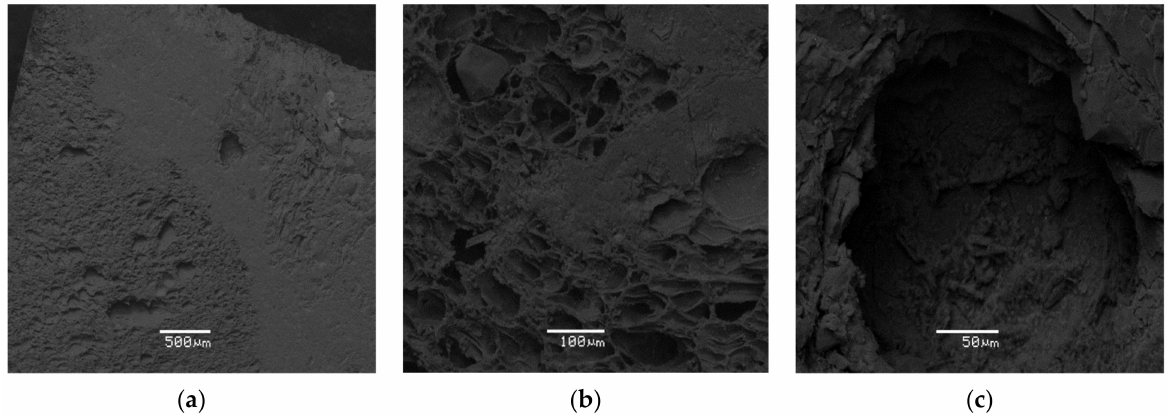
Figure 8. SEM photos of PeCaPu concrete samples: ( a ) ITZ area, ( b ) and ( c ) aggregate pore filled by cement